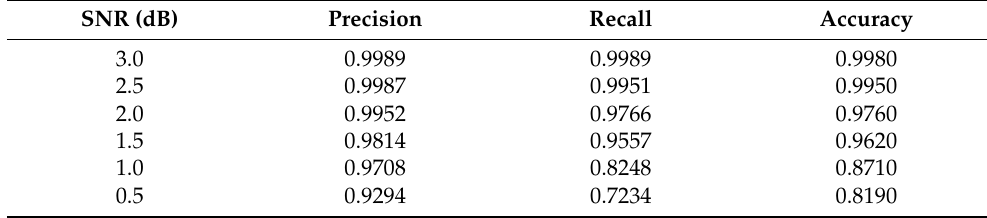
Table 2. Test results with an interval of 0.5